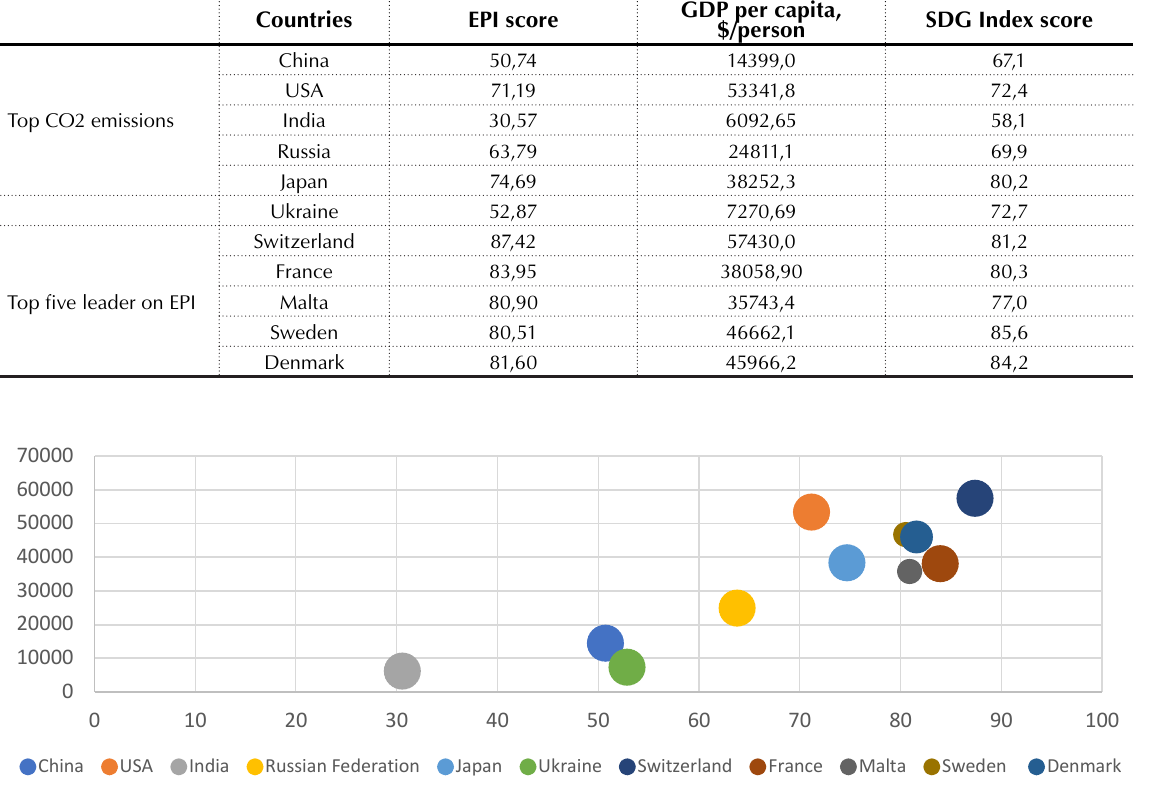
Figure 4. Comparison analysis of GDP per capita and EPI score by countries Source: Created by the authors on the basis of Environmental (2018), SDG